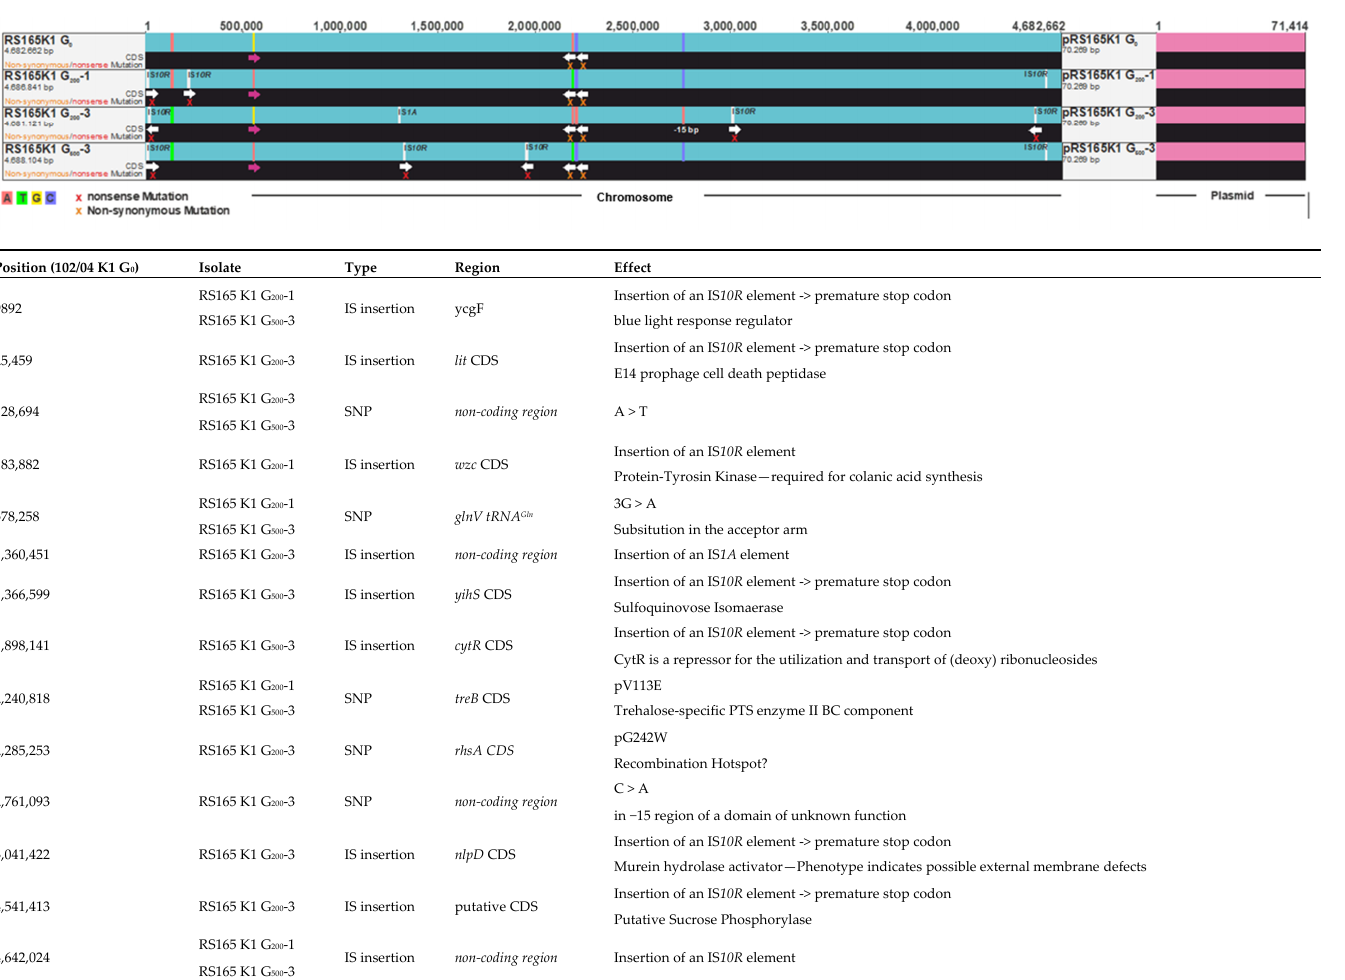
Figure 4. Schematic presentation of the genetic changes of transconjugant isolates RS165 K1 after long-term growth . Mutations in the chromosomes and amino acid changes are marked at the respective positions. Base pair substitutions are marked by color. Positions of modified IS elements are highlighted by white bars. White arrows point towards changes in coding sequences.